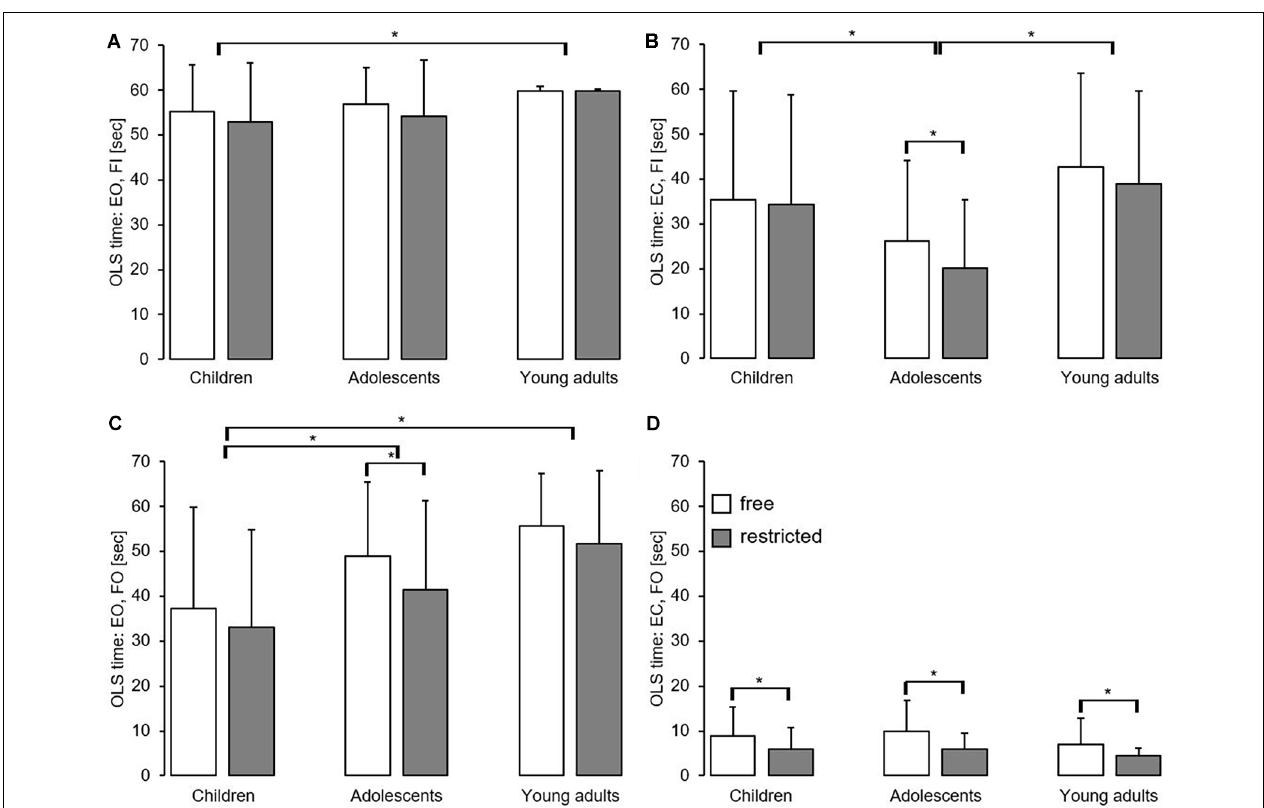
FIGURE 3 | Effect of free vs. restricted arm movement and task difficulty by age group on static balance performance using the one-legged stance with eyes opened on firm ground (A) , with eyes closed on firm ground (B) , with eyes opened on foam ground (C) , and with eyes closed on foam ground (D) . Values are means ± standard deviations. *Significant difference ( p < 0.05) between free and restricted arm movement conditions and age groups. EC, eyes closed; EO, eyes opened; FI, firm ground; FO, foam ground; OLS, one-legged stance.